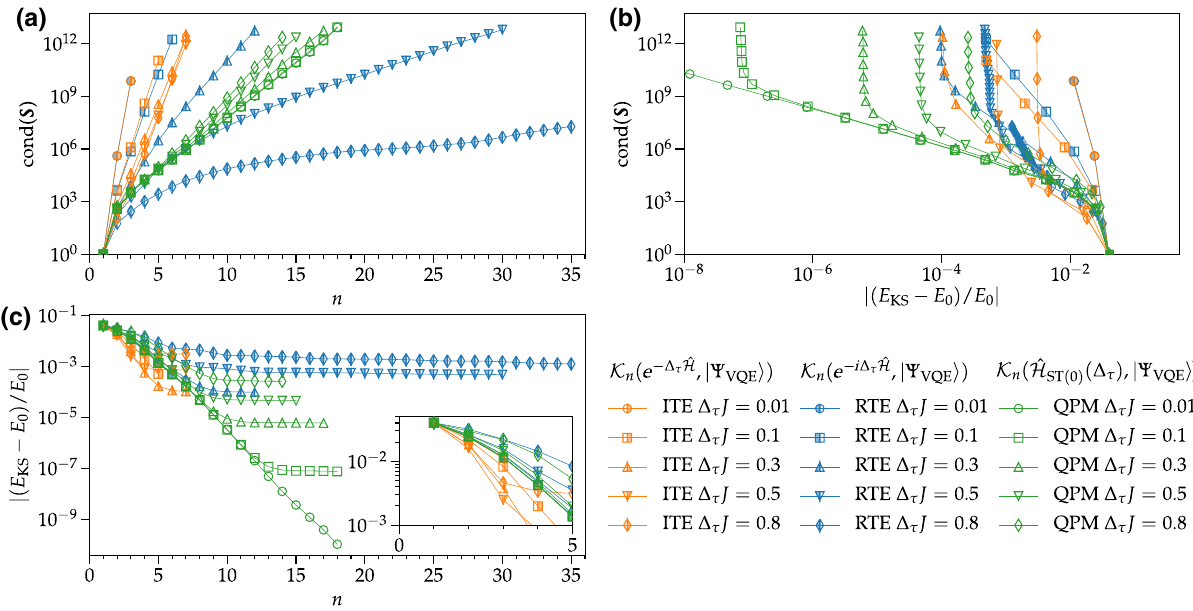
FIG. 9. Same as Fig. 8 but for the reference state | ψ (cid:3) = | (cid:6) VQE (cid:3) . Notice that the results for ITE and RTE with (cid:3) τ J = 0.01 are identical in this